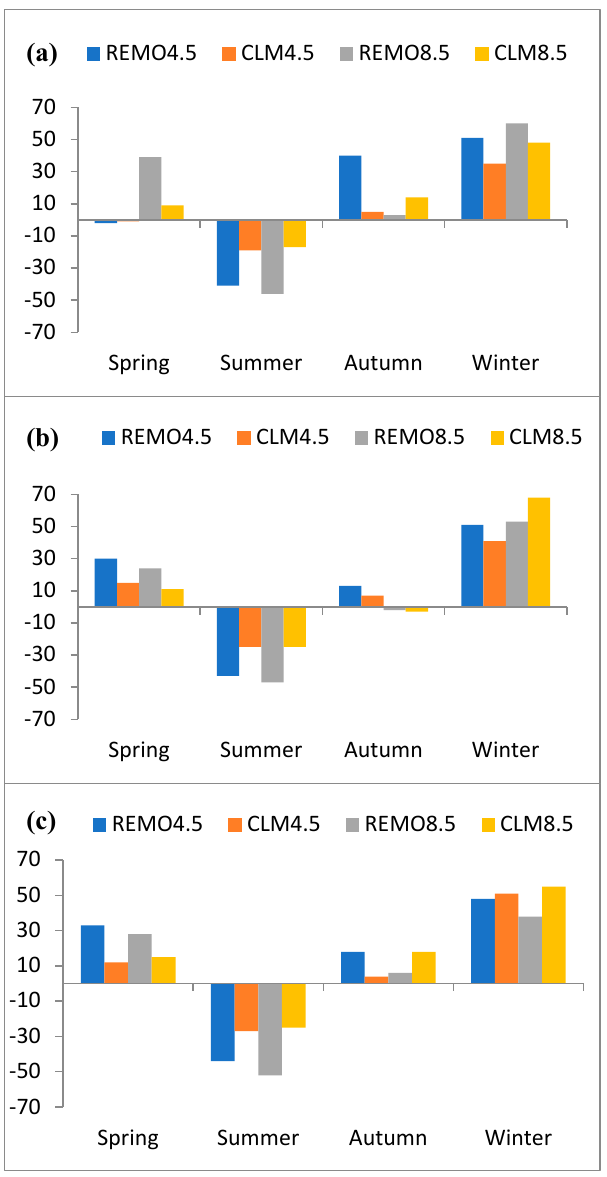
Figure 7. Changes in precipitation as percentual differences compared with baseline for: ( a ) short, ( b ) mid, and ( c ) long term.